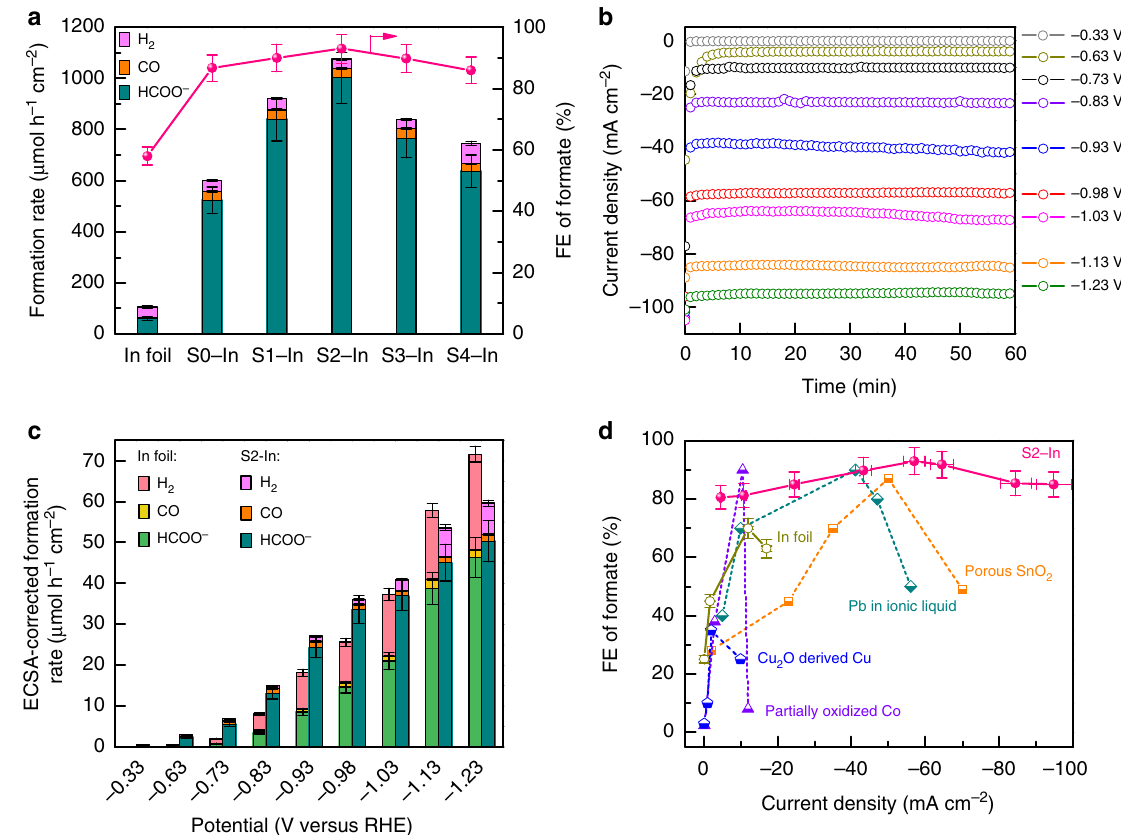
Fig. 1 CO 2 RR performances of sulfur-doped indium catalysts. a Formation rates of H 2 , CO and HCOO − and FE of formate for In foil and S − In catalysts at − 0.98 V (versus RHE) for 1 h. b Current density for S2 − In catalyst over 1 h of reaction at each given potential (versus RHE). c ECSA-corrected current density and FE of formate for In foil and S2 − In catalyst at each given potential for 1 h. d Plot of FE of formate versus current density for S2 − In catalyst and some typical catalysts reported to date (see Supplementary Table 1 for details). Reaction conditions: CO 2 -saturated 0.5 M KHCO 3 solution in H-type electrochemical cell with platinum plate as the counter electrode and saturated calomel electrode (SCE) as the reference electrode. The experiments in each case were performed at least for three times. The error bar represents the relative